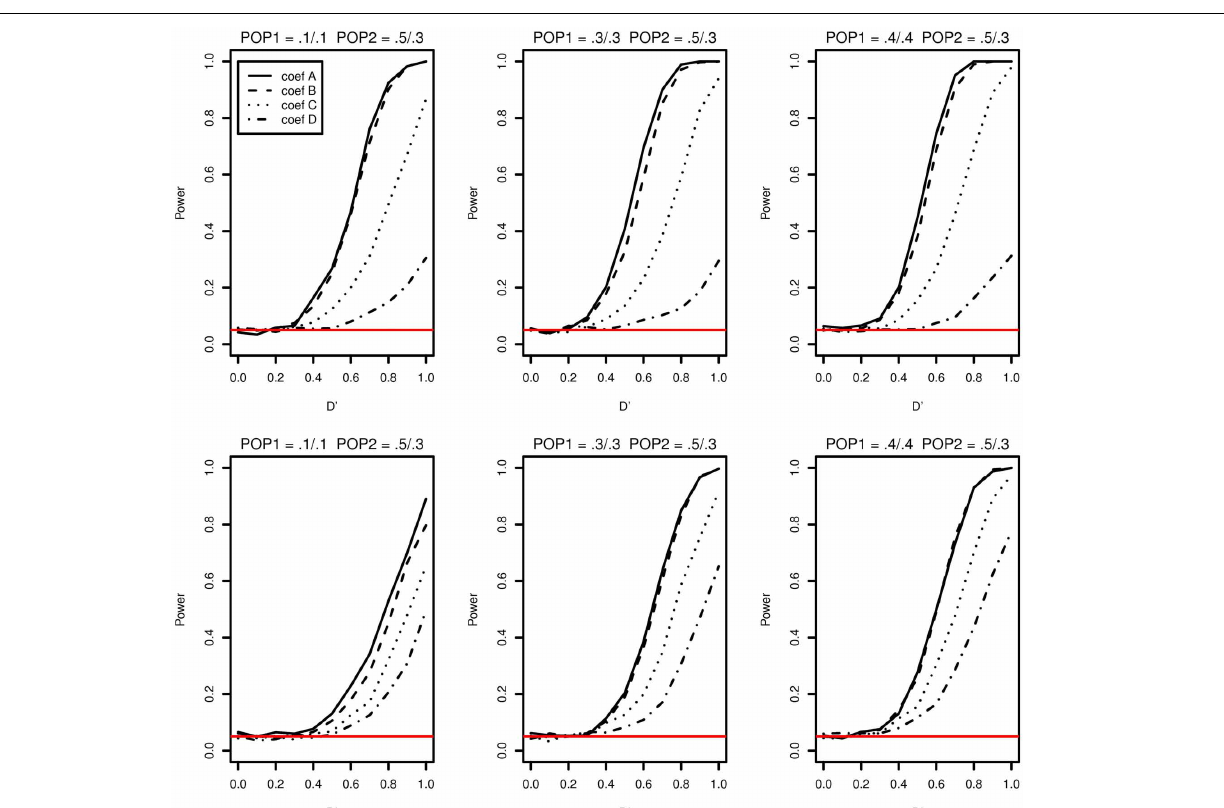
FIGURE 3 | Type I error and power of detecting interaction effects with different MAFs when population stratification is present with the equal sample size 1000 (500 families) in two populations. Plots in the top row: β 0 = 0 for Population 1 and β 0 = 0 . 2 for Population 2 sharing the same regressioncoefficients coefA : β 1 = 0, β 2 = 0,and β 12 = 0 . 5, coefB : β 1 = 0 . 25,